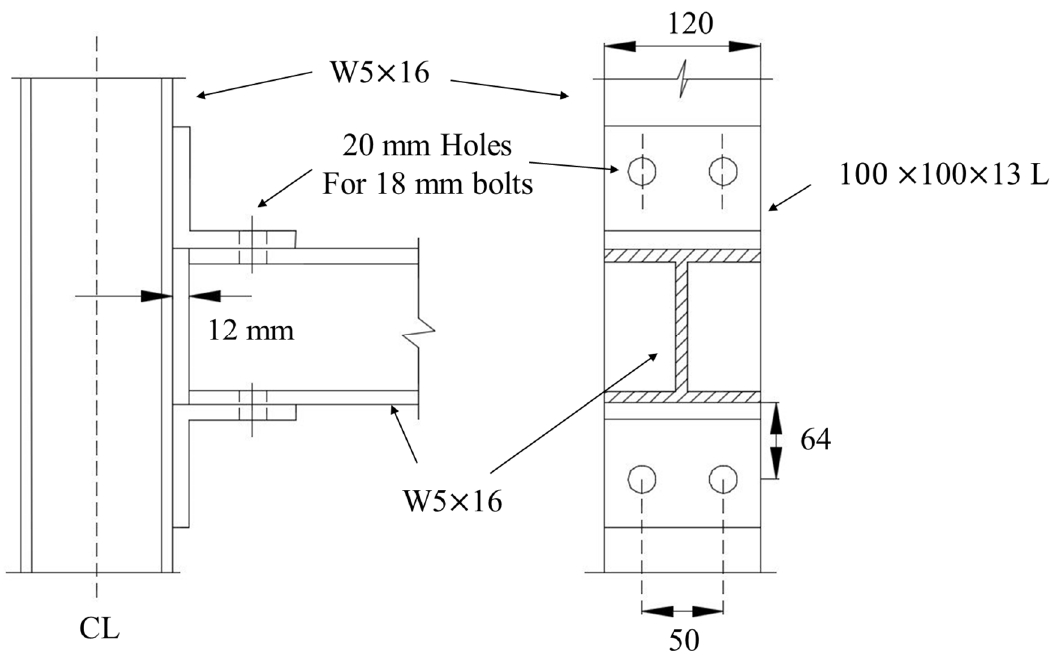
Figure 11. Top and seat angle connection [46].